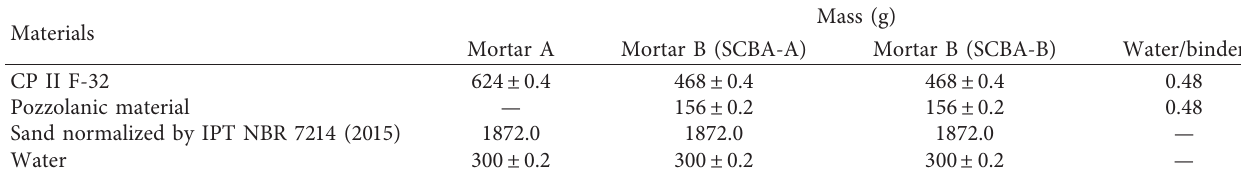
Table 1: Determination of pozzolanic activity index with